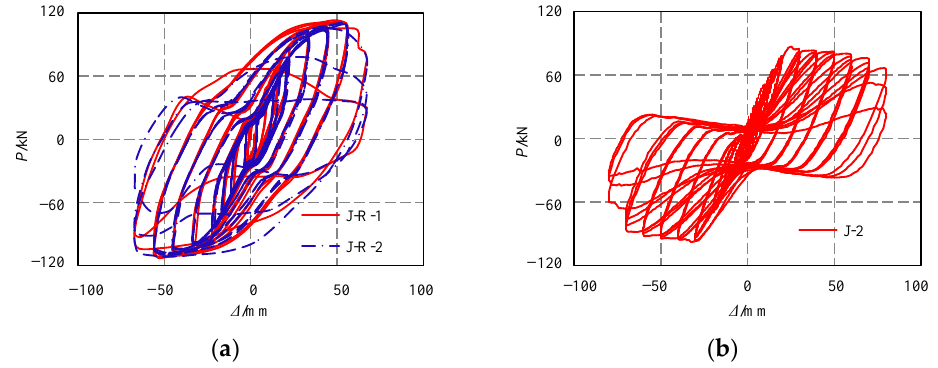
Figure 11. ( a ) Hysteretic curves for specimens J-R-1 and J-R-2; ( b ) hysteretic curve for specimen J-2.